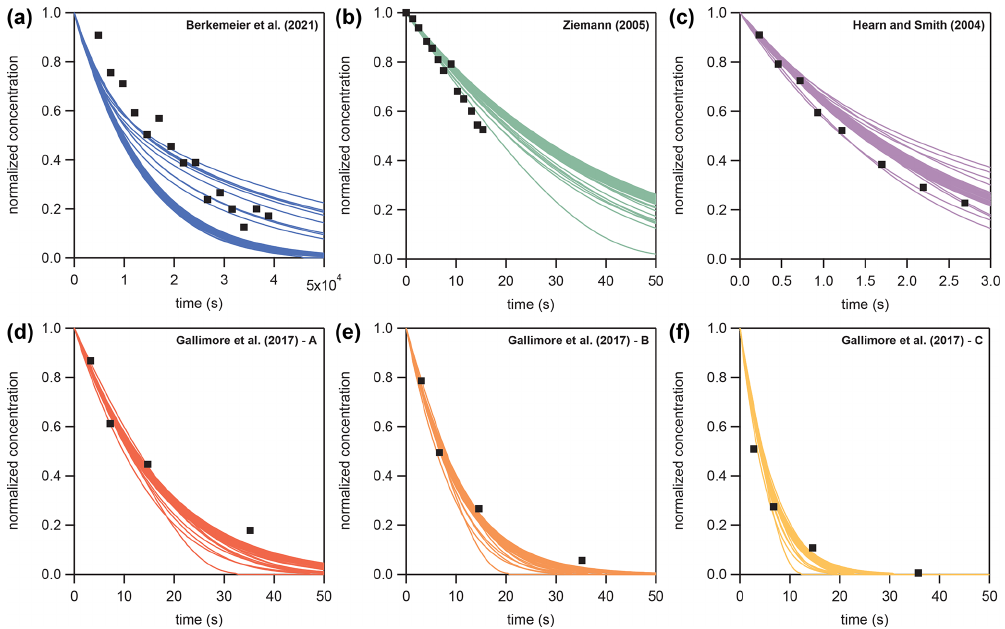
Figure B2. Fit ensembles of KM-SUB ( N = 50, colored lines) with MSLE < 0 . 016 to six literature datasets (black square markers) of oleic acid aerosol ozonolysis displayed as normalized oleic acid concentrations ( N Y ,t /N Y , 0